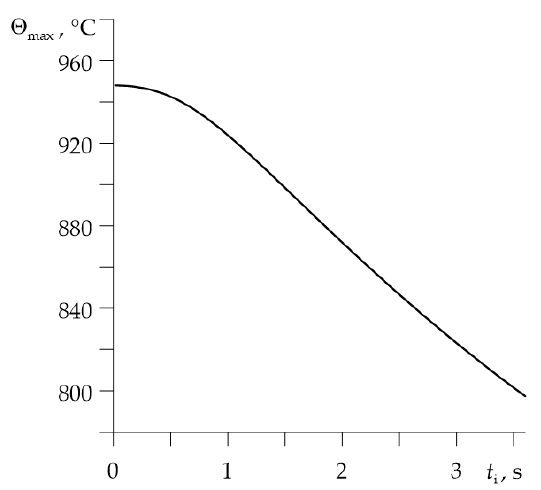
t of contact pressure i